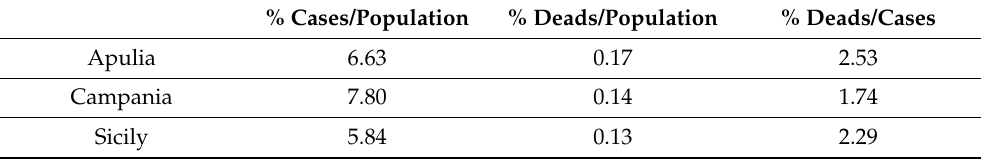
Table 4. Spread and mortality in the regions of southern Italy with the highest number of